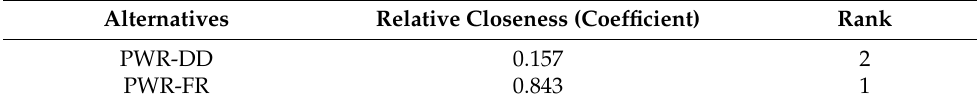
Table 6. Evaluation results of direct disposal and Pyro-SFR fuel cycle using TOPSIS.